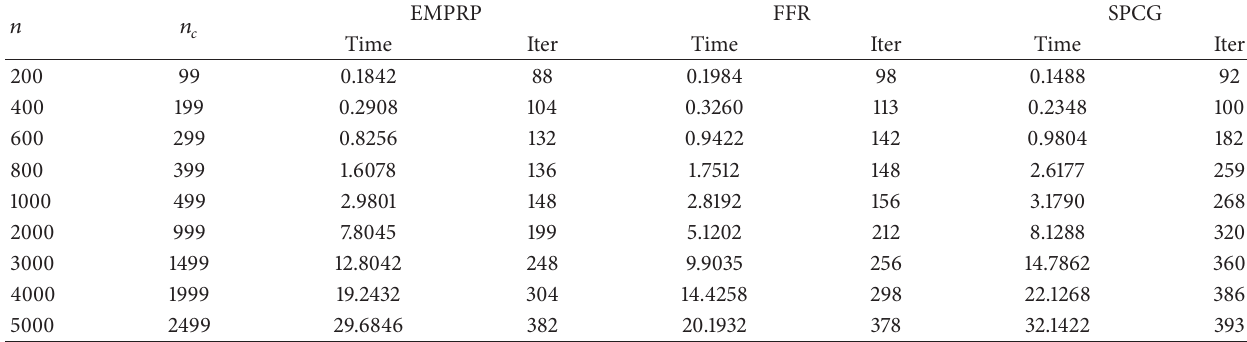
Table 6: Test results for Problem 10 with given initial